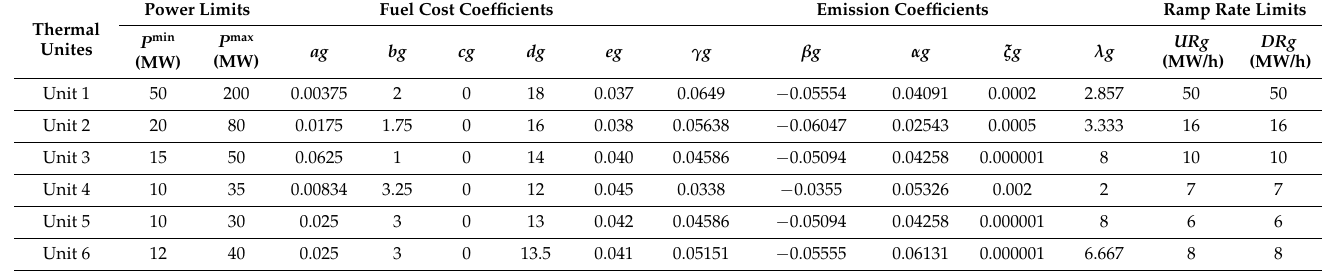
Table 1. The cost data of six thermal production units and their emission coefficients.